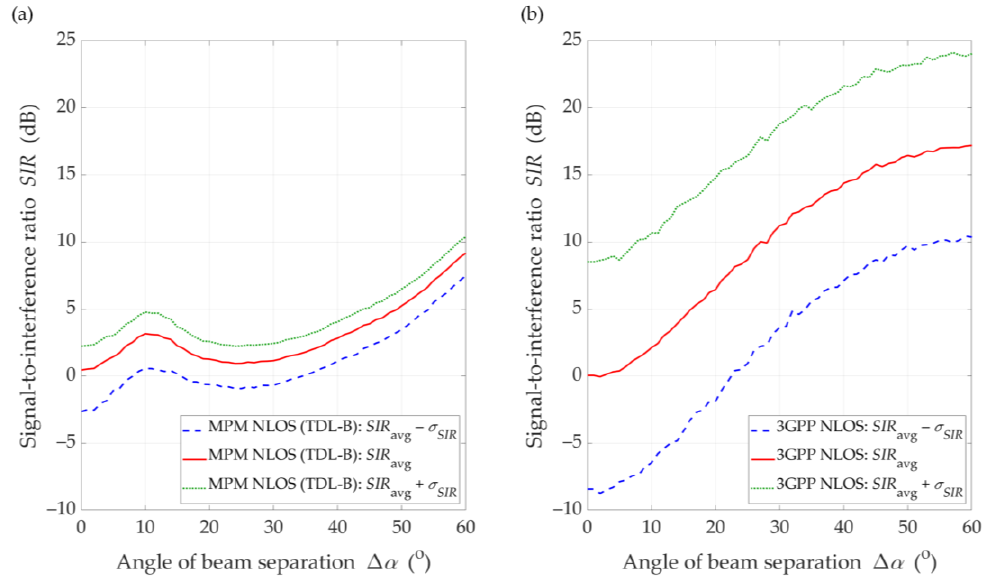
Figure 15. SIR comparison between ( a ) MPM and ( b ) 3GPP model for DL scenario, D = 100 m, and NLOS conditions.